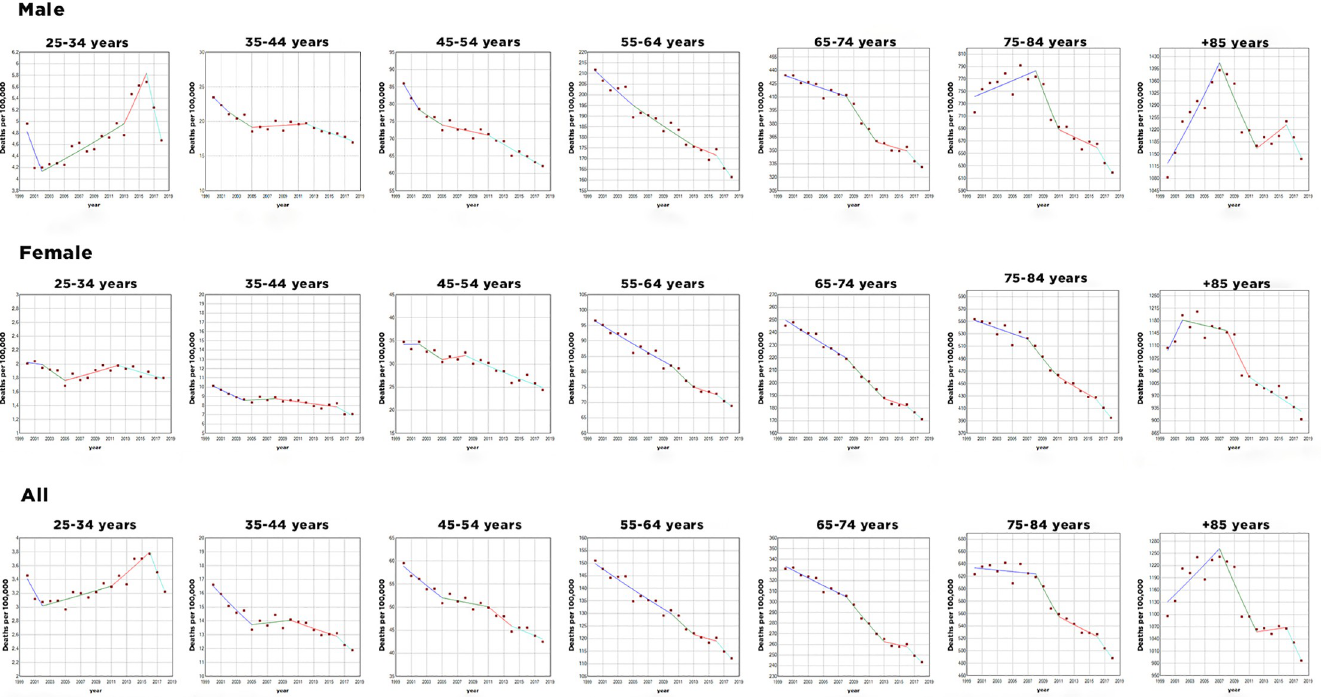
Fig 2. Trends in age and sex-specific mortality rates per 100,000 for coronary heart disease, Brazil. 2000–2018.